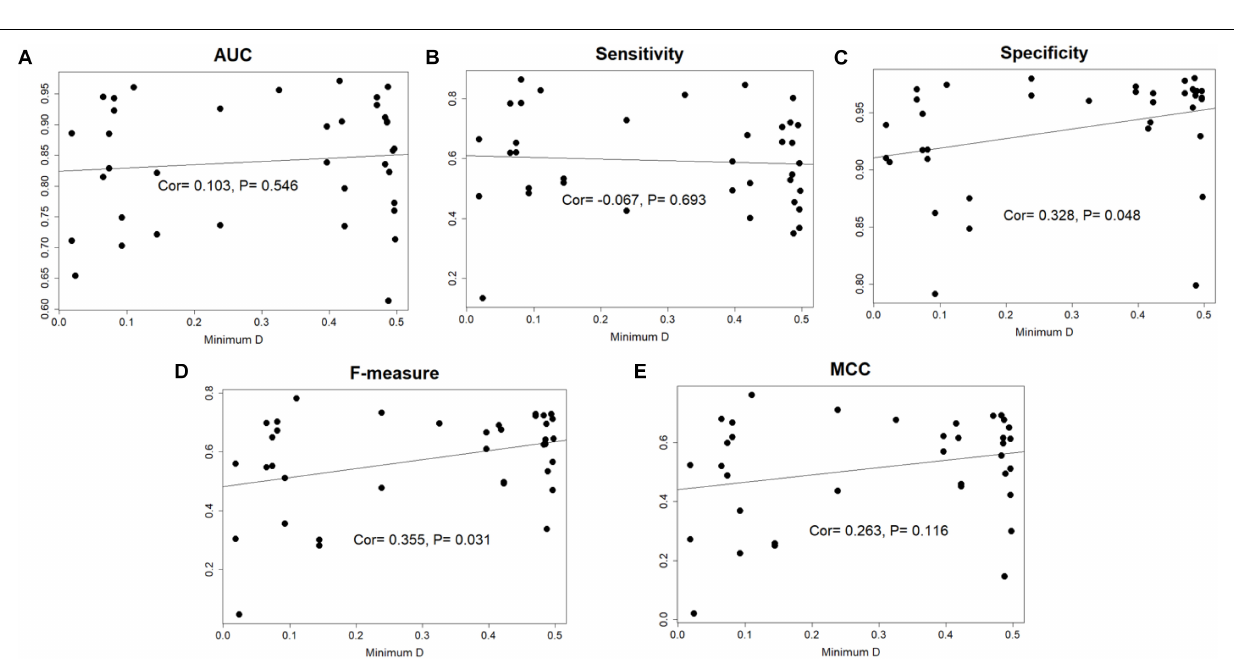
Frontiers in Microbiology |